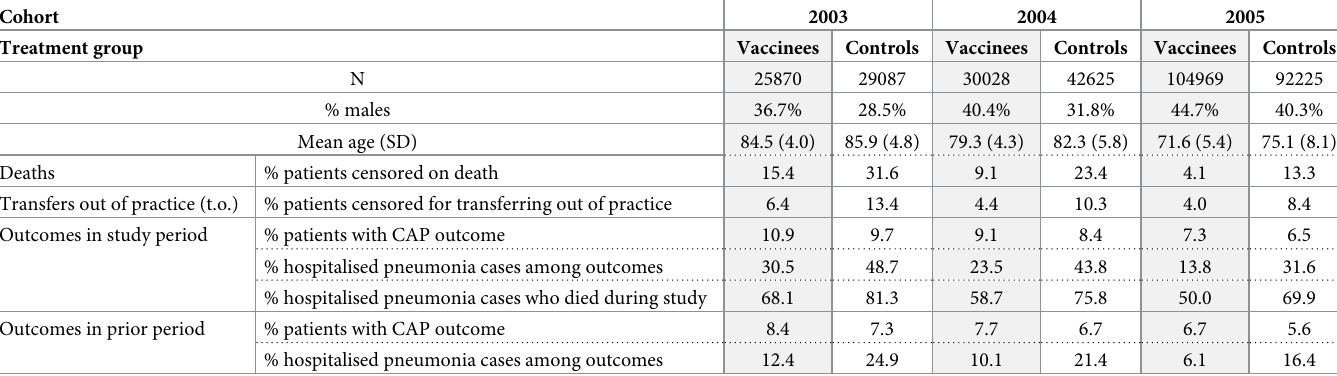
Table 1. Rates of composite CAP outcome, death and, censoring for each cohort from 2003 to 2005. Cohort Treatment group